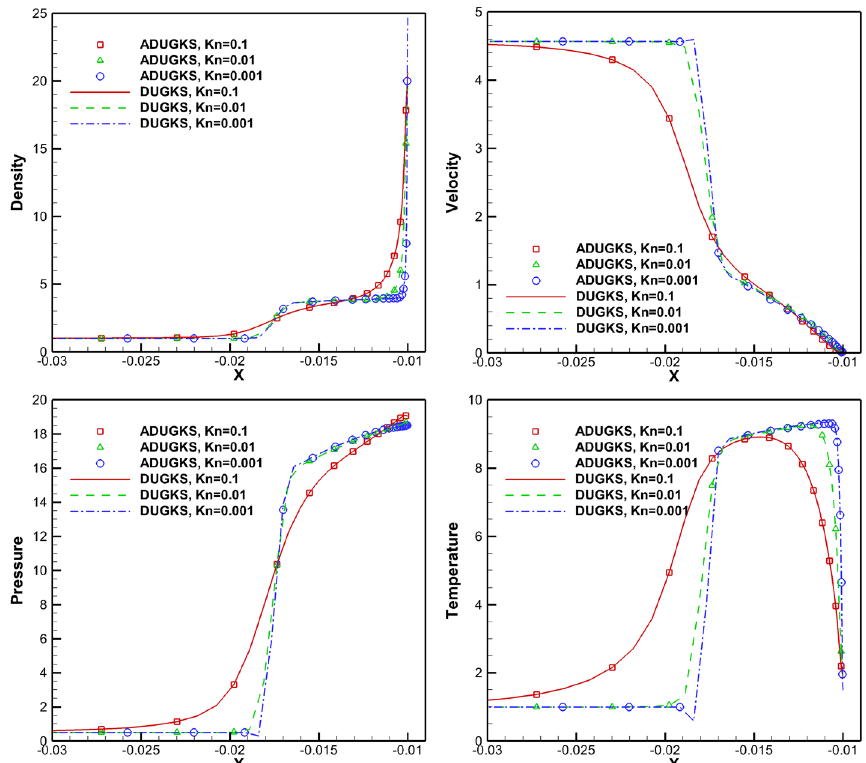
Fig. 17 Comparison of density, u -velocity, pressure and temperature profiles along the stagnation line for flow around a circular cylinder with different Knudsen